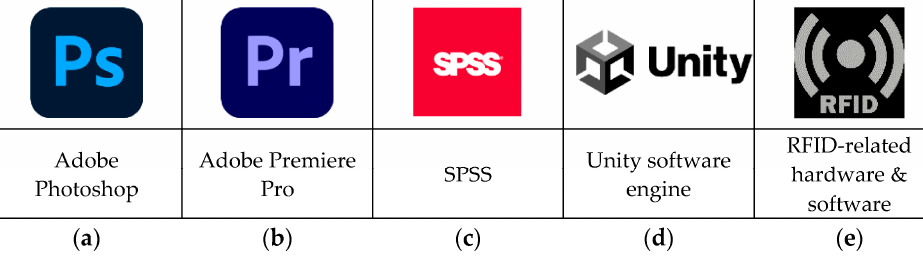
Figure 8. Software and hardware used in proposed system constructed in this study. ( a ) Adobe Photoshop for image processing. ( b ) Adobe Premiere Pro for video editing. ( c ) SPSS for statistical analysis of collected data. ( d ) Unity software engine for creating games on multiple platforms. ( e ) Software and hardware for RFID-related signal processing.